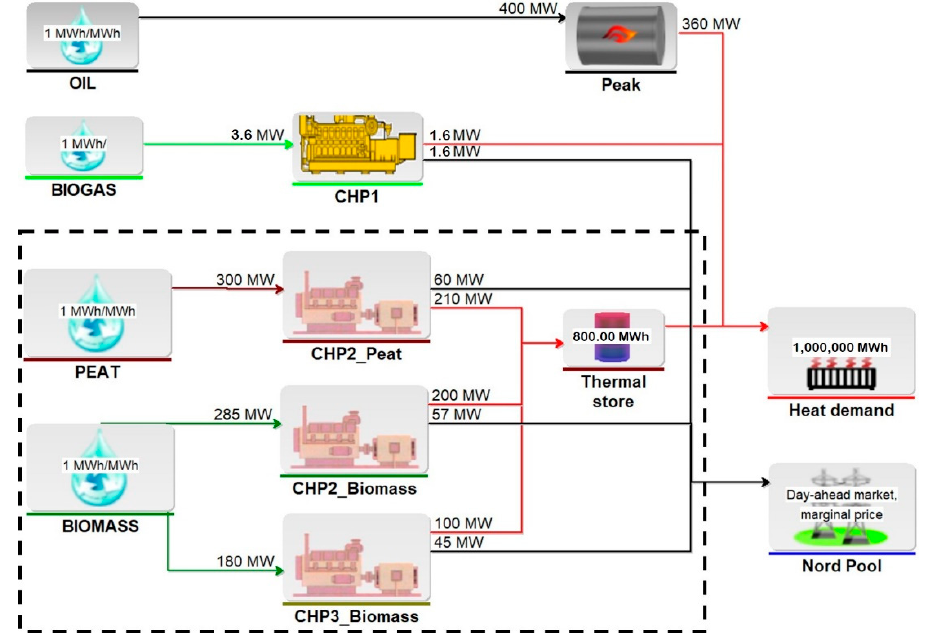
Figure 1. EnergyPRO Model used in simulation 1. The power plant area is shown inside the dashed line.